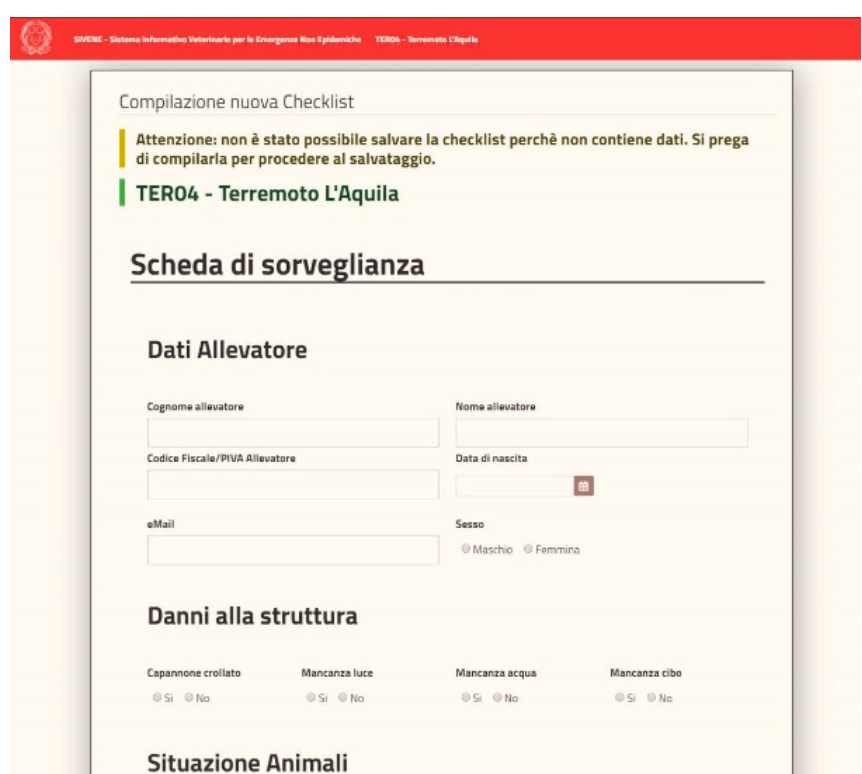
Figure 4. Web form example of the dynamic checklists used for the entry of damage data collected for the planning of intervention measures (i.e., farmer’s personal information, type of structural damages, and number of dead or injured animals).